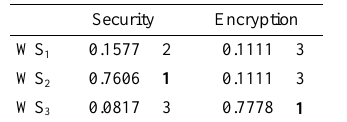
Table 9. Eigenvectors and rankings for Case 2